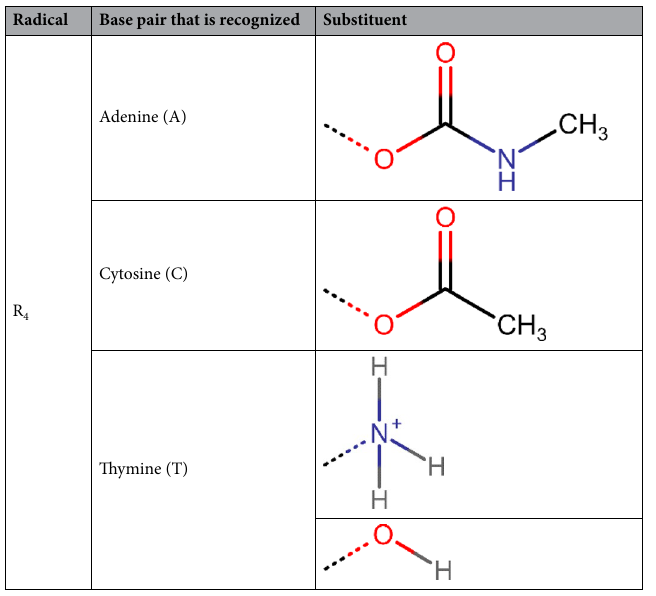
Table 1. Modifications of the HASDI linker aimed at recognizing different nucleic bases in the DNA